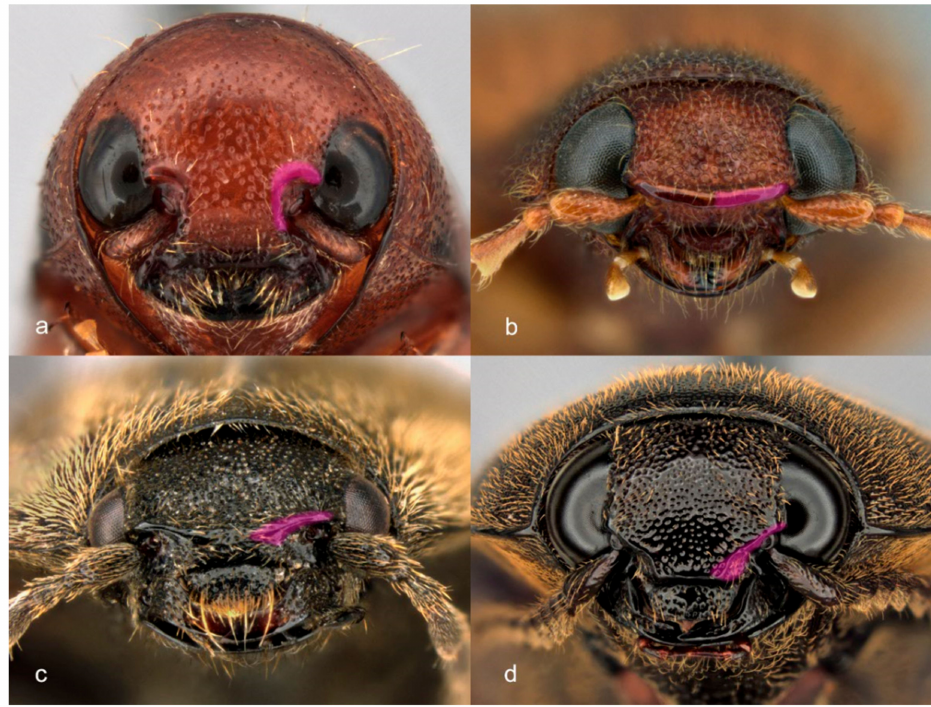
Figure 5. Frontal views of Elateridae heads showing character states of supra-antennal carinae with carina highlighted in part. ( a ) following outlines of antennal cavities (Thylacosterninae: Pterotarsus bimaculatus Laporte, 1835); ( b ) directed mesad and fused at midline forming shelf (Dendrometrinae: Athous orvus Becker, 1974); ( c ) directed mesad and fading near the midline (Dendrometrinae: Proster- non sp.); ( d ) directed anteromesad to the anterior edge of frontoclypeus (Elaterinae: Orthostethus infuscatus Germar,